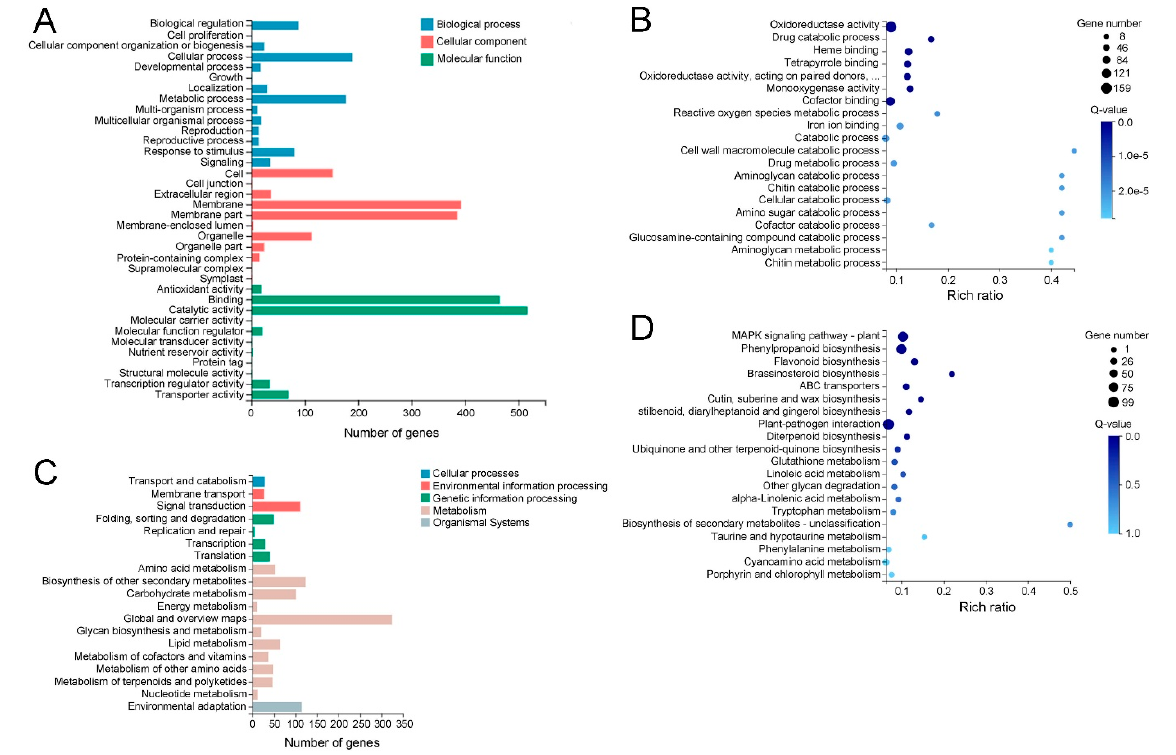
Figure 7. GO and KEGG analyses of differentially expressed genes (DEGs) in MT vs. WT. ( A , B ) GO classification and enrichment analyses. ( C , D )The classification and enrichment analyses of KEGG pathways of DEGs in MT vs. WT. The rich ratio is the ratio of the number of DEGs annotated in a given GO term or pathway to the number of all genes annotated in the GO term or pathway.